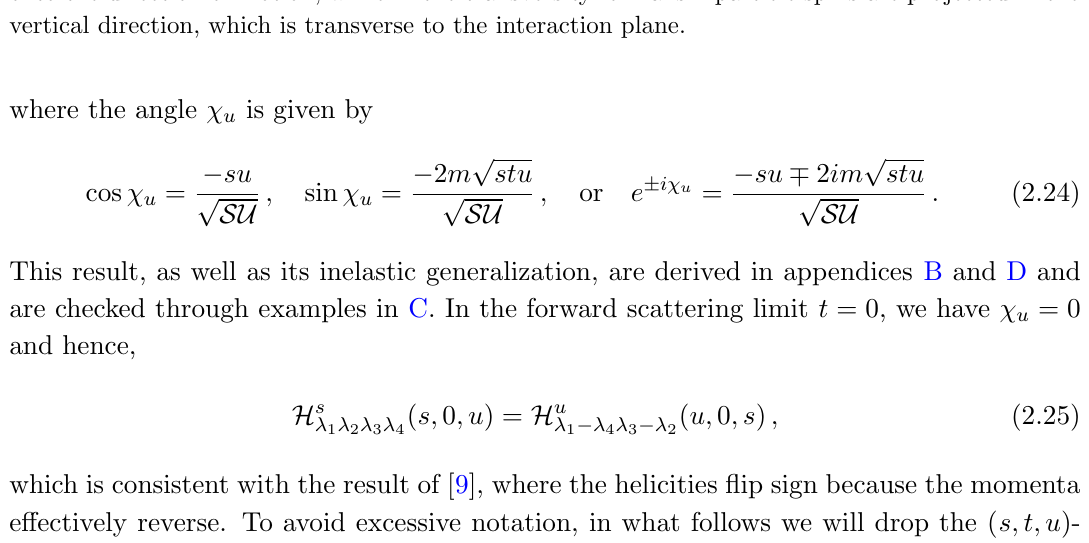
Figure 1 . The di(cid:11)erence between the helicity and transversity formalism. The horizontal plane ( xz plane) is the particle interaction plane. In the helicity formalism particle spins are projected onto the direction of motion, while in the transversity formalism particle spins are projected in the vertical direction, which is transverse to the interaction